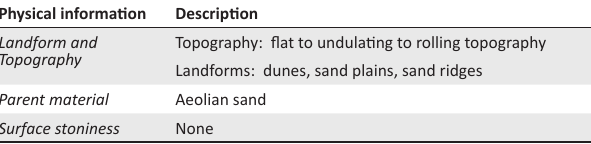
TABLE A1.7a: Differentiating characteristics of the ferralic Arenosols.